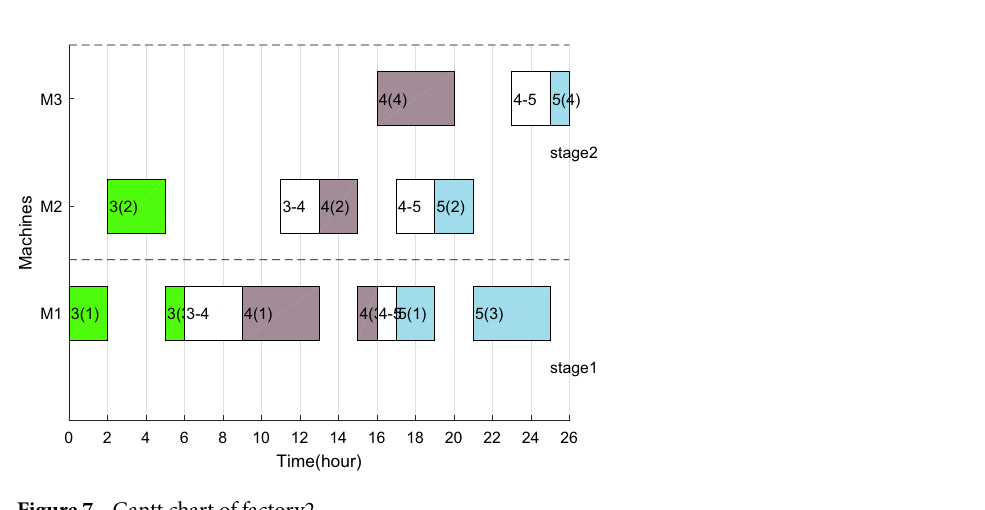
Figure 7. Gantt chart of